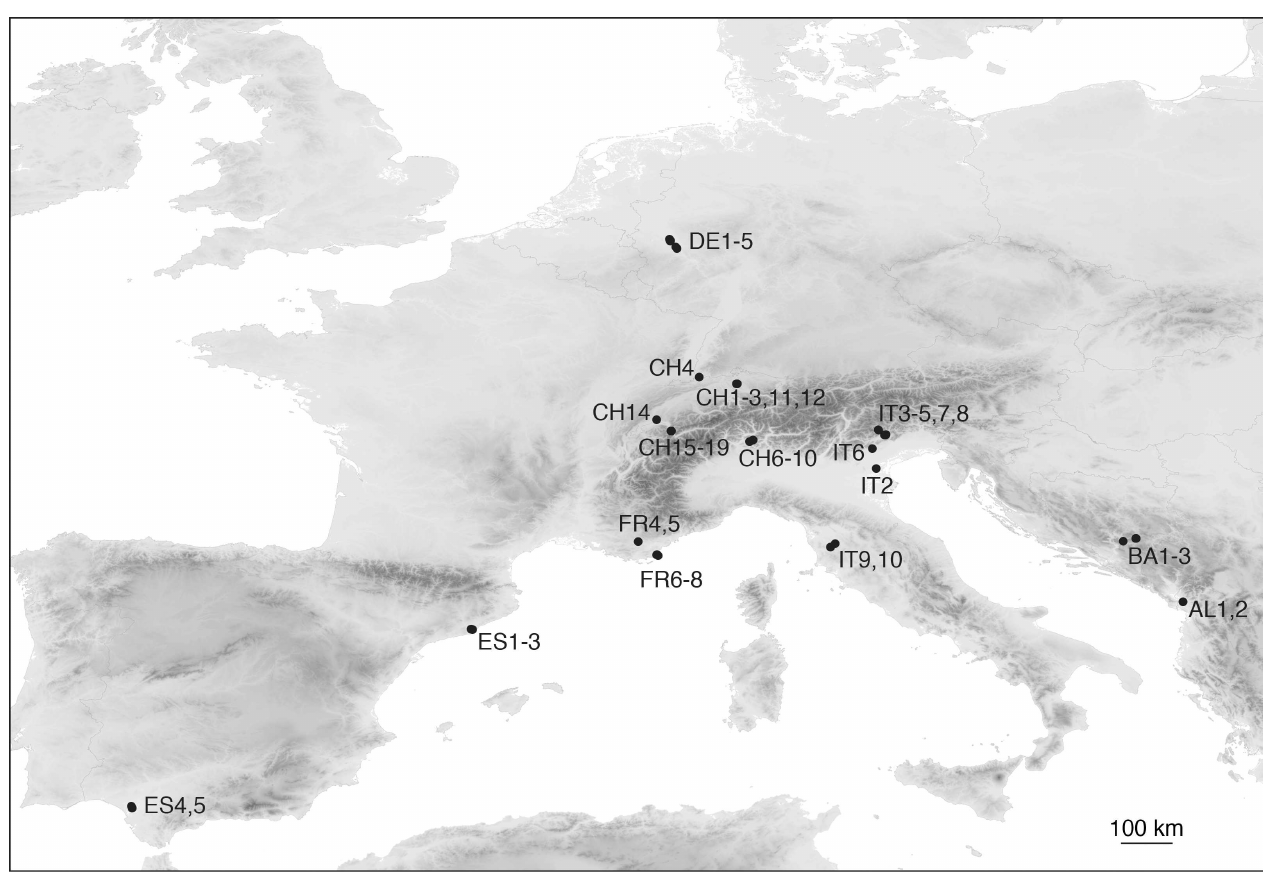
Fig 1. Map showingall samplinglocationsacross Europe. AL: Albania;BA: Bosnia-Herzegovina; CH: Switzerland;DE: Germany; ES: Spain; FR: France; IT: Italy. Locationdetailsare given in S1 Table.